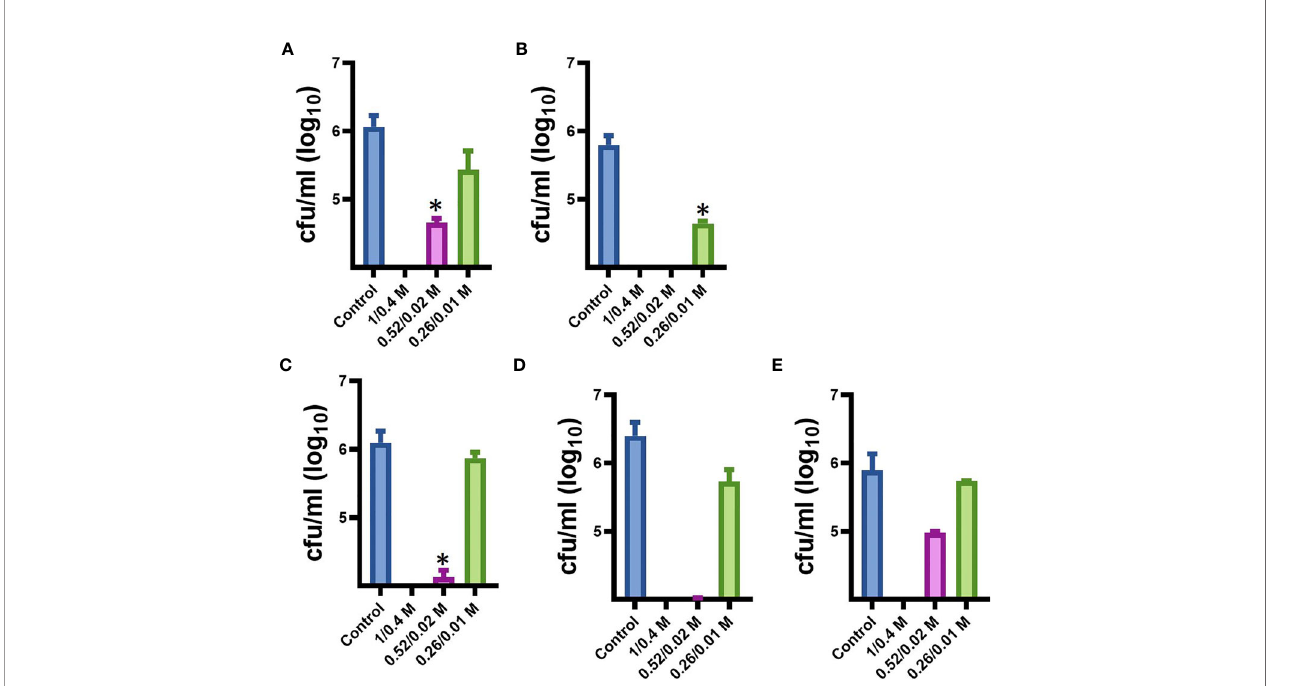
FIGURE 3 | Minimum inhibitory concentration of MoWa against MRSA and MSSA strains. S. aureus strain (A) NRS408, (B) NRS49, (C) NRS236, (D) NRS230, or (E) NRS242 was inoculated in a six-well plate and treated with a mixture levulinic acid (LA) and SDS at a concentration of 1/0.04 M, 0.52/0.02 M, or 0.26/0.01 M for 1 h. Bacteria were removed, diluted and plated onto BHI agar plates containing 7% of NaCl to obtain colony counts (cfu/ml). Error bars represent the standard errors of the means calculated using data from at least three independent experiments. *p<0.05 compared to